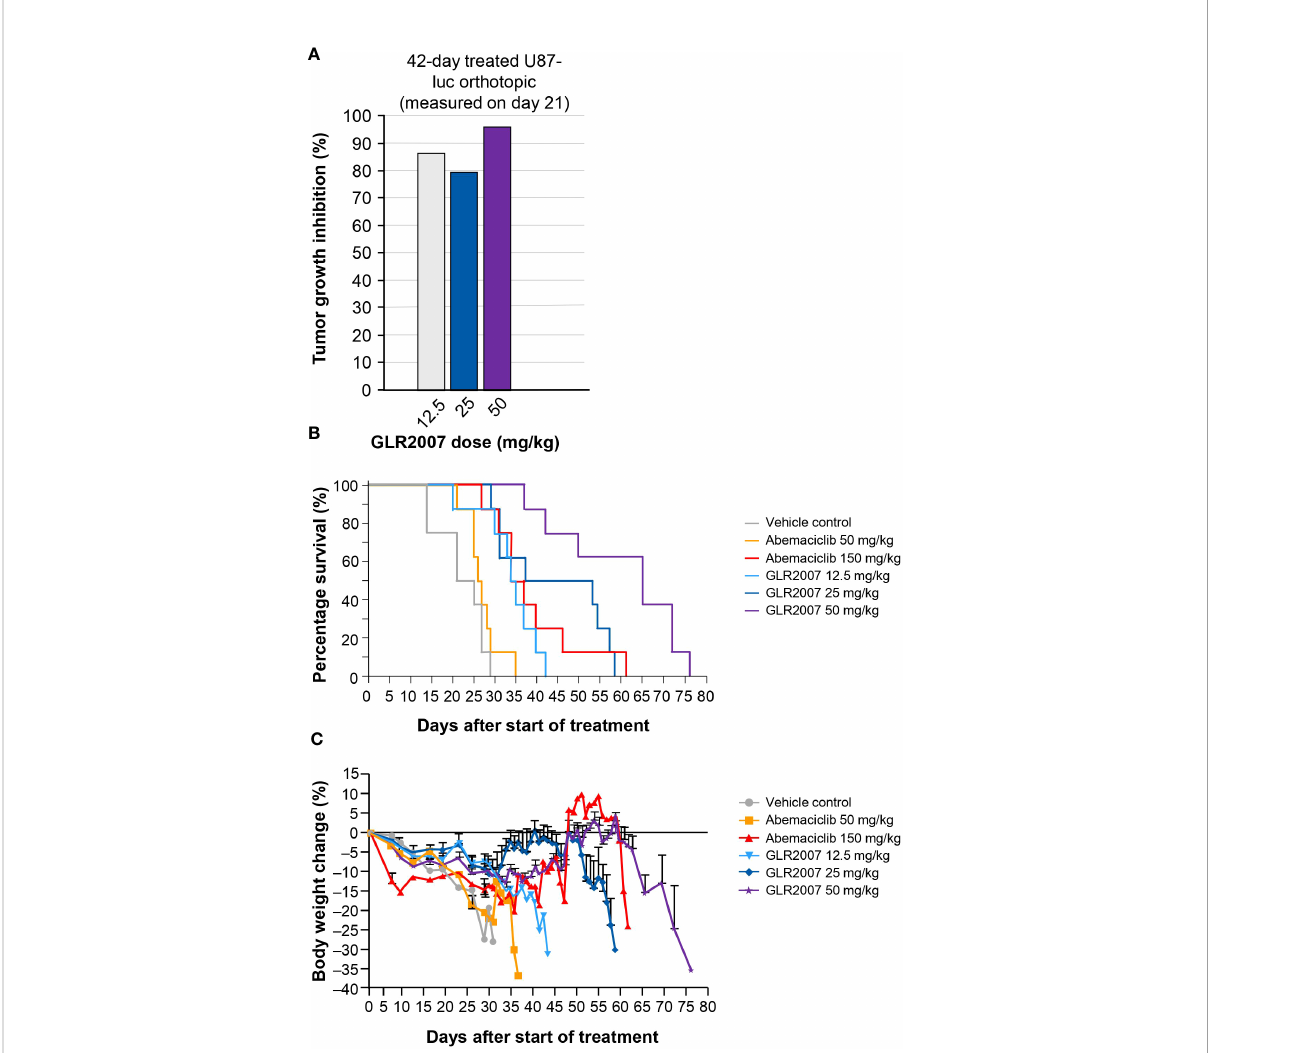
FIGURE 3 Tumor growth inhibition, survival rates and body weight changes in a mouse GBM xenograft model following treatment with a range of doses of GLR2007 or abemaciclib. (A) Tumor growth inhibition in a mouse orthotopic GBM xenograft model following 42 days of treatment with a range of doses of GLR2007, administered once daily, compared with vehicle control. The tumor growth was measured on day 21. (B) Kaplan – Meier survival curves of 42-day treated orthotopic U87-luc xenograft mice following treatment with a range of doses of GLR2007 or abemaciclib. (C) Relative body weight changes of orthotopic U87-luc xenograft mice treated for 42 days with a range of doses of GLR2007 or abemaciclib. Error bars represent the error of the mean. GBM,